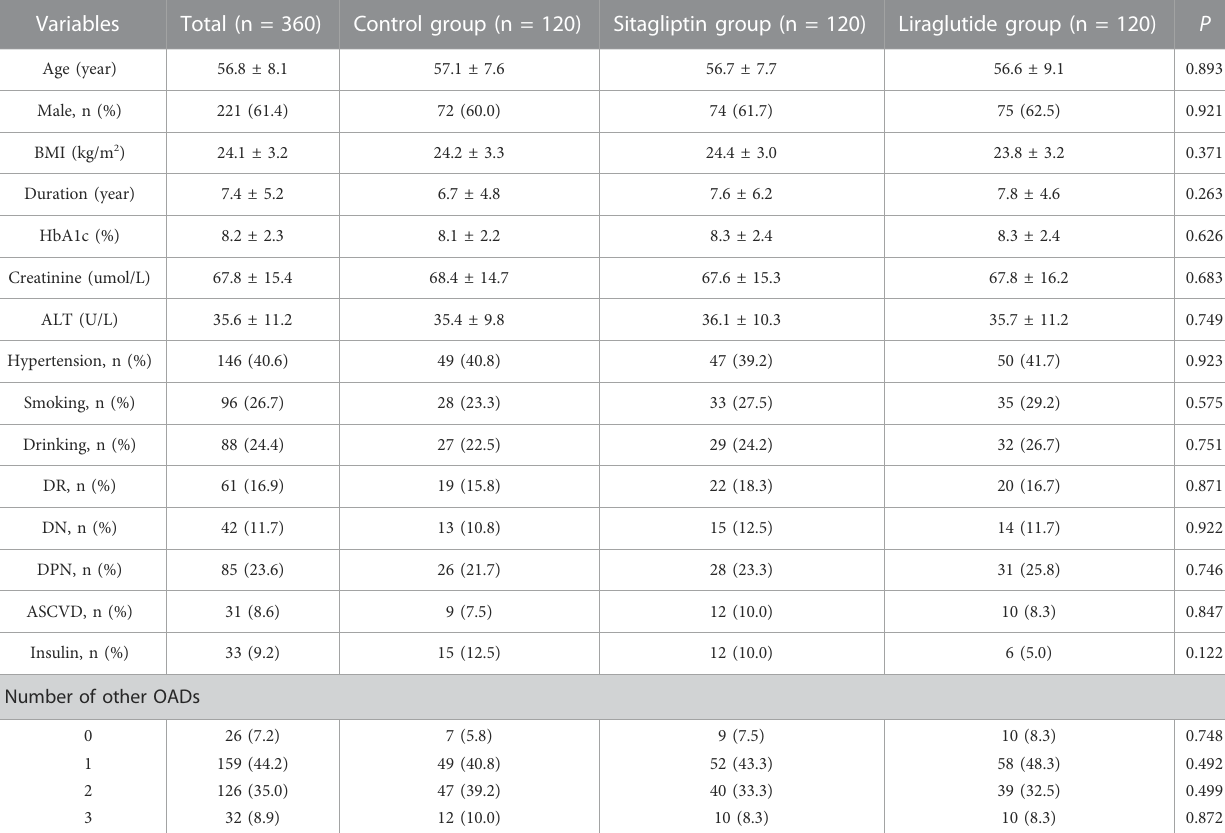
TABLE 1 Baseline demographic and clinical